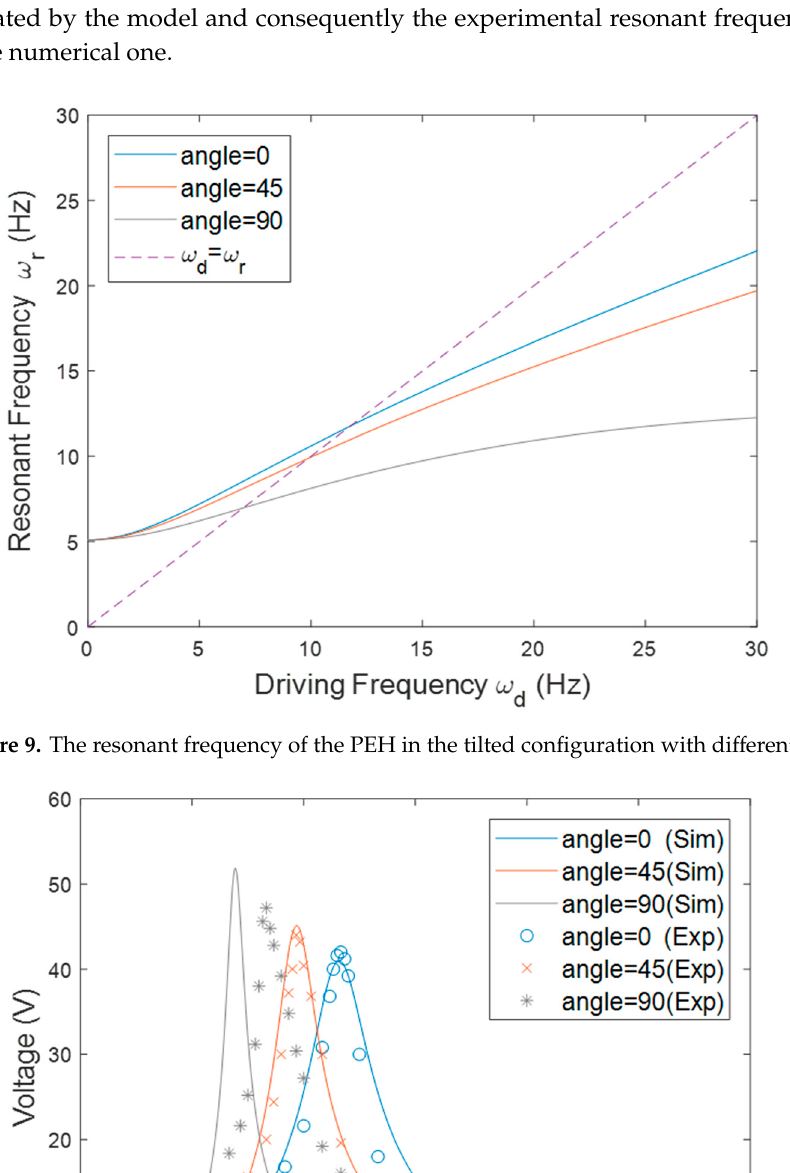
Figure 11. The illustration of axial load on the PEH in the tilted configuration. 4. Conclusions This study examined a PEH in different orientations under rotational excitations. The installation orientation of the PEH influenced the axial component of the centrifugal force acting on the beam so the dynamics of the PEH were affected correspondingly. The dynamics of the rotational PEH was theoretically modeled and an experimental study was conducted for validation. Three configurations—outward, inward, and tilted orientations—were studied and compared. In the outward orientation, the resonant frequency of the PEH increased when the installation radius was extended, because of the increase of the centrifugal force. However, the experiment and simulation showed that the resonant frequency of the PEH in the inward orientation was raised as the installation radius was shortened. Finally, the tilt angle of the PEH had a strong influence on the resonant frequency of the PEH. When the tilt angle increased from 0° to 90°, the increase of the